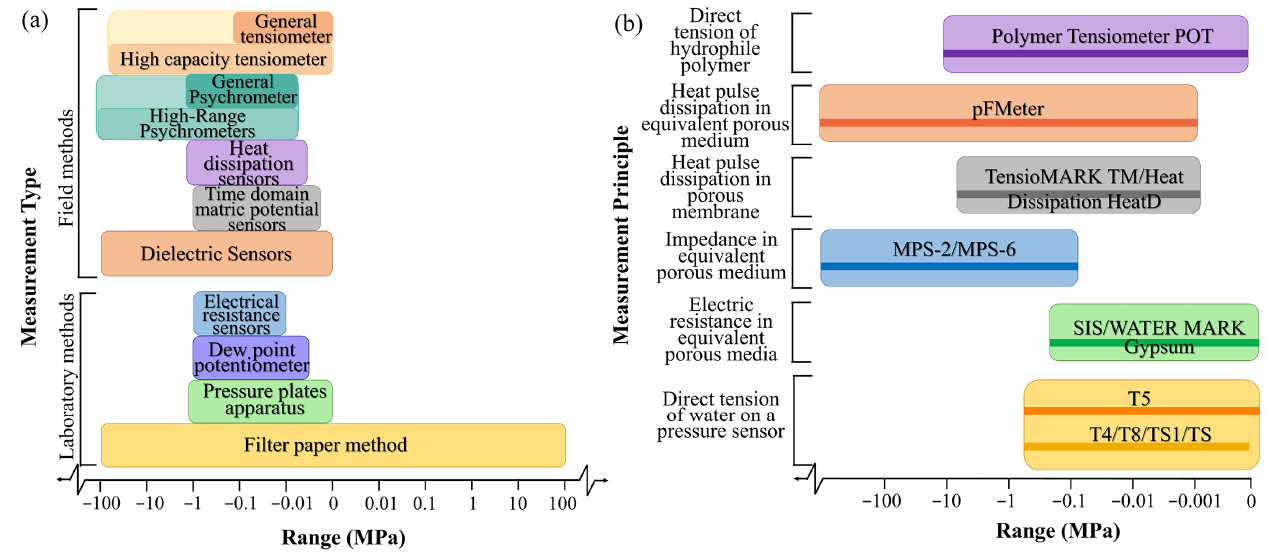
Figure 3. Primary SMP measurement methods ( a ) and some new SWP sensors ( b ), modified from Jackisch et al. [9] and Vereecken et al. [48]. Table 1. Comparison of SWP measurement methods.